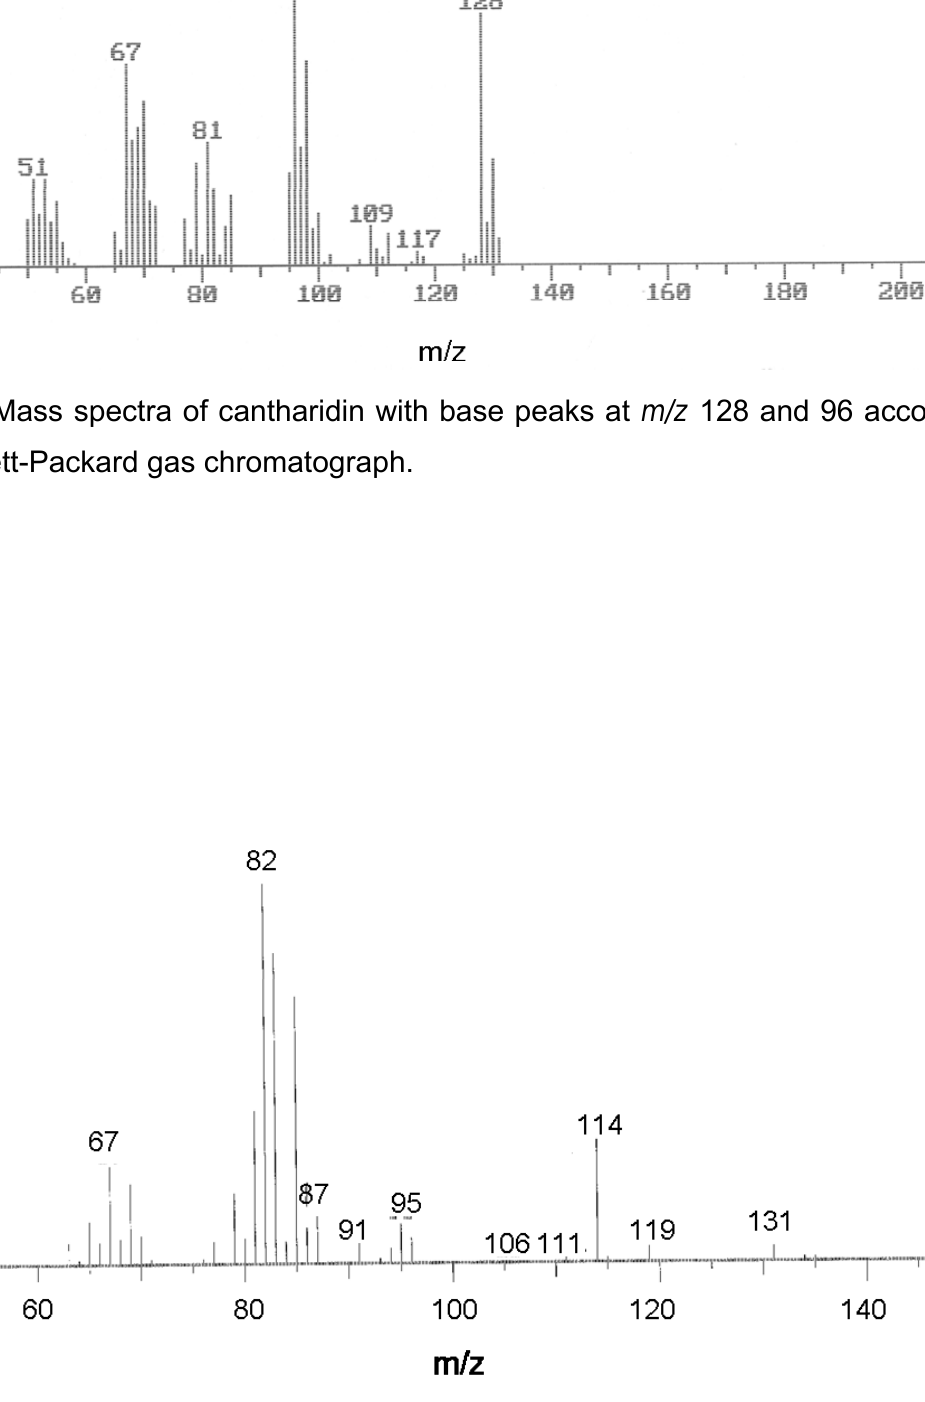
Figure 2. Mass spectra of demethylcantharidin with base peaks at m/z 114 and 82 according to a Hewlett-Packard gas